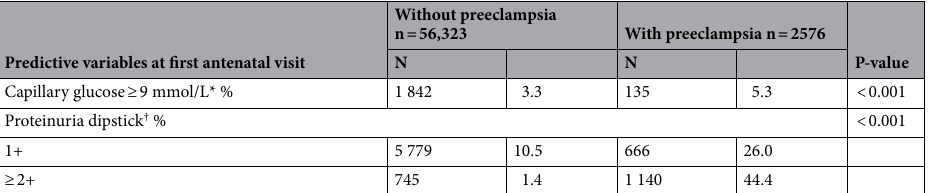
Table 2. The predictive variables of capillary glucose and proteinuria, collected at repeated time points in antenatal care in the study population of 58 899 nulliparous women. *Dichotomous time-varying predictor: if ≥ 9 mmol/L at any antenatal visit, then positive. † Categorical time-varying predictor, if 1+ or ≥ 2+, at any antenatal visit, otherwise